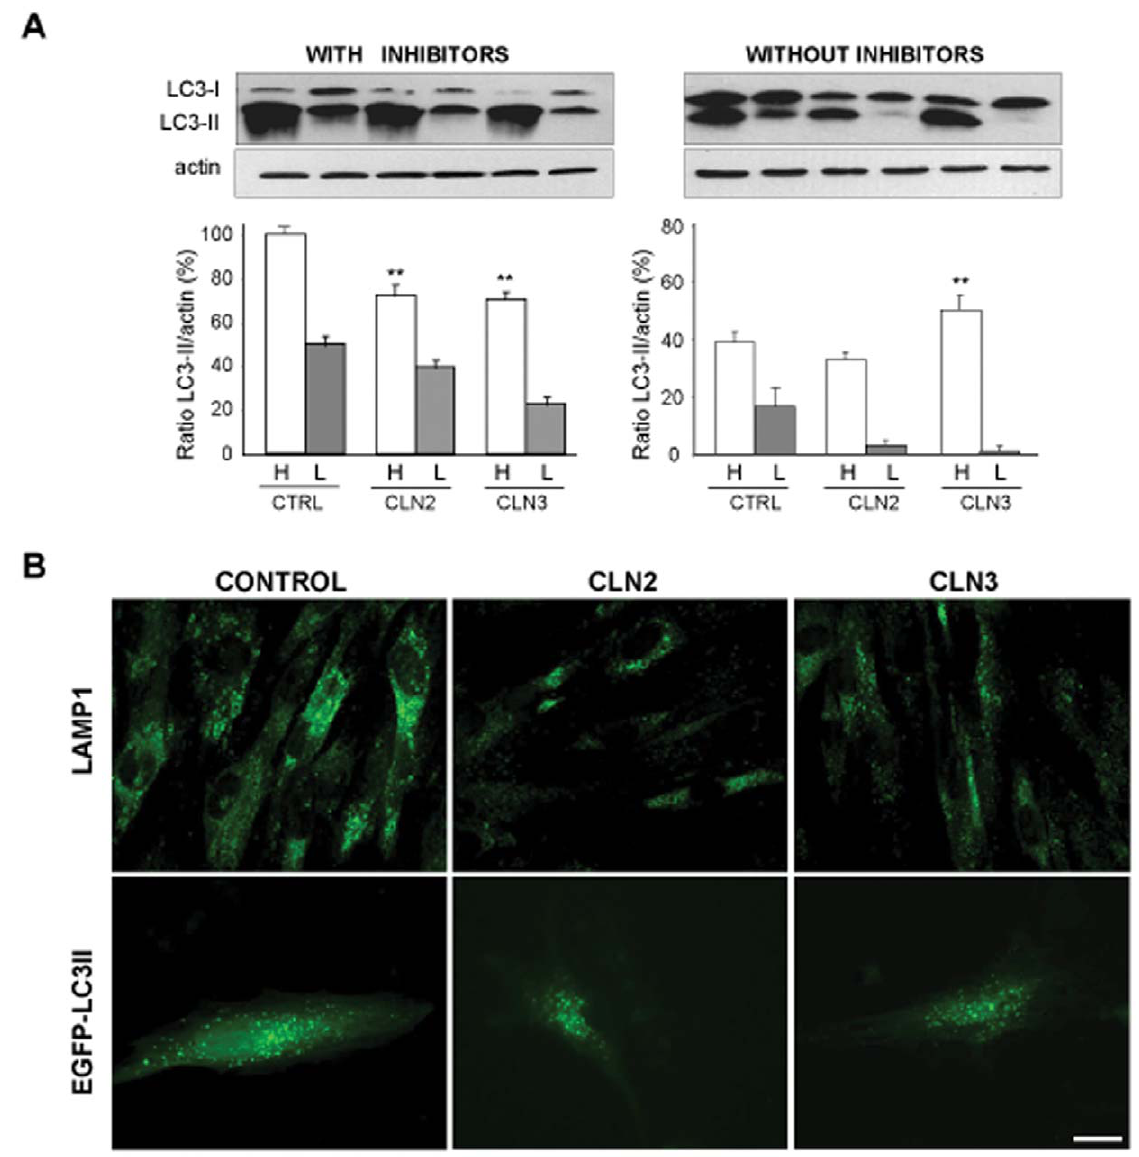
Figure 2. Reduced autophagosome formation in CLN2 and CLN3 fibroblasts and decreased autophagosome maturation in CLN3 cells. (A) Total extracts from control (CTRL), CLN2 and CLN3 fibroblasts incubated under high (H) and low (L) proteolysis conditions and with or without lysosomal inhibitors (see Material and Methods) were analyzed by western-blot using LC3 and, as a loading control, actin antibodies. The position of LC3-I, and LC3-II bands are indicated on the left. Densitometric measurements from three different experiments are shown below. Results are presented as LC3-II/actin ratios and are expressed as percentages of the control values with inhibitors under high proteolysis conditions. Stars indicate statistically significant differences under high proteolysis conditions from the corresponding control values (**p , 0.01). (B) Representative fluorescence images of control, CLN2 and CLN3 fibroblasts incubated in high proteolysis medium for 2 h at 37 u C. Upper micrographs: immunocytochemistry with anti-LAMP1. Lower micrographs: control, CLN2 and CLN3 fibroblasts, 48 h after transfection with pEGFP-LC3. Bar: 20 m